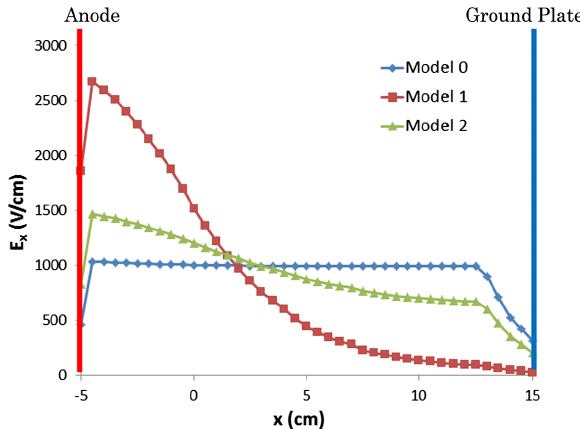
FIG. 7. x dependence of the E x distributions on the kicker central plane at z ¼ 1150 mm and y ¼ 0 mm for three models.